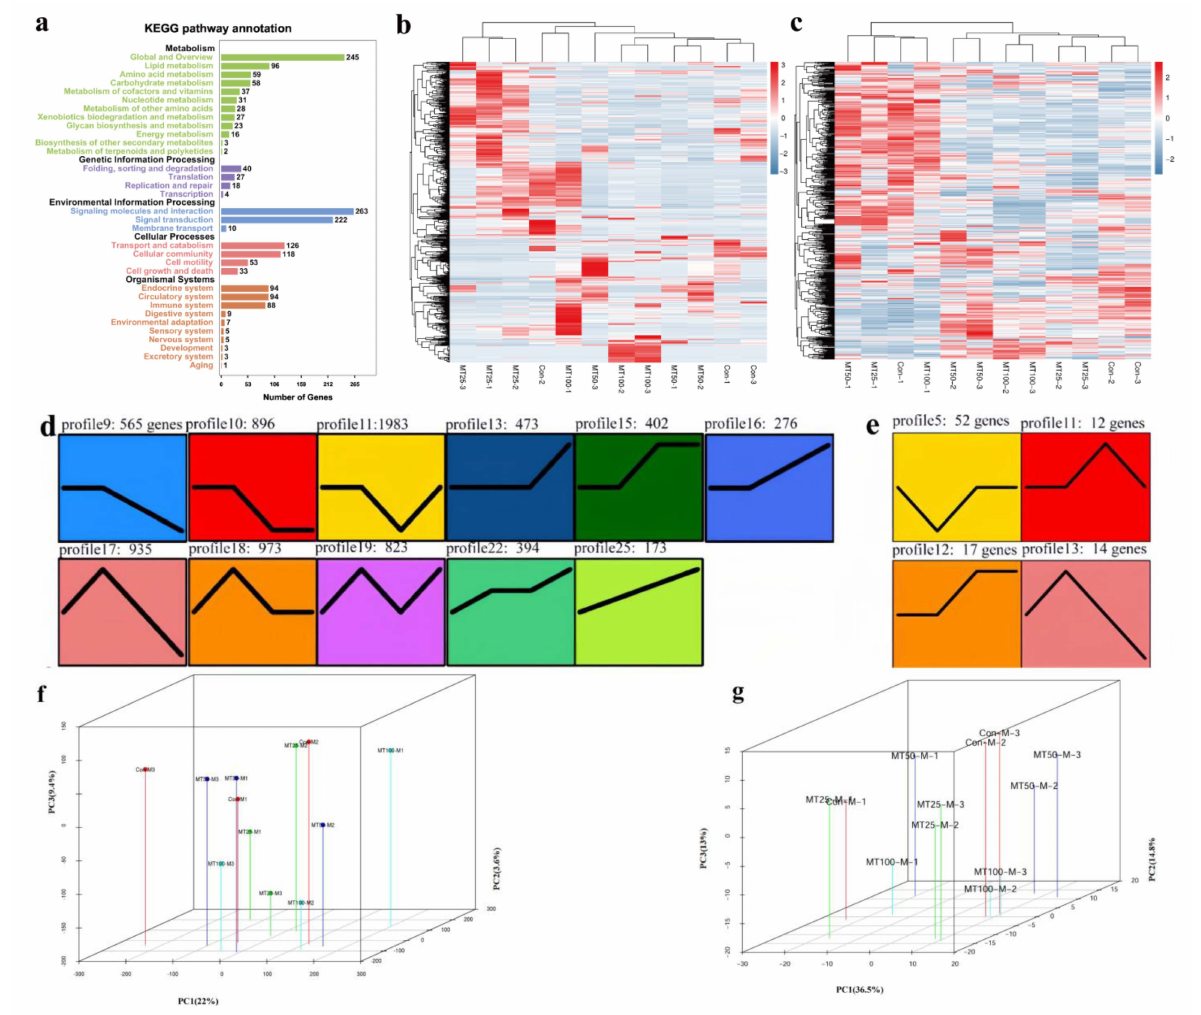
Figure 2. STEM analysis of RNAs ( a , b , d , f ) and miRNAs ( c , e , g ). ( a ) Enriched KEGG pathway annotation of RNA. Statistical summary of distribution of genes in each pathway for each trend. Rich factor refers to the ratio of the number of genes in the pathway entry in the differentially expressed genes to the total number of genes in the pathway entry in all genes. The larger the rich factor, the higher the degree of enrichment. Q-value is the p -value corrected by multiple hypothesis testing, and the value range is 0 to 1. The closer to zero, the more significant the enrichment is. The graph is drawn with the top 20 pathways sorted by Q-values, from small to large. ( b ) Heatmaps of RNAs ( n = 3). ( c ) Heatmaps of miRNAs ( n = 3). ( d ) STEM analysis of RNAs ( n = 3). ( e ) STEM analysis of miRNAs ( n = 3). The IDs of the trends and the numbers of genes for the trends are shown at the top of the figure; trend blocks with color ( p < 0.05): the trends with significant enrichment and the trend blocks with similar trends have the same color. ( f ) PCA analysis of RNAs. ( g ) PCA analysis of miRNAs. The variation between samples was constrained in the PCA analysis (22.0% and 36.5% of the variance for RNAs and miRNAs alone, PC1; p < 0.05). In both panels, different colors correspond to samples from different 17MT concentrations. The percentage of variation explained by each axis refers to the proportion of the total data variance explained by the constrained